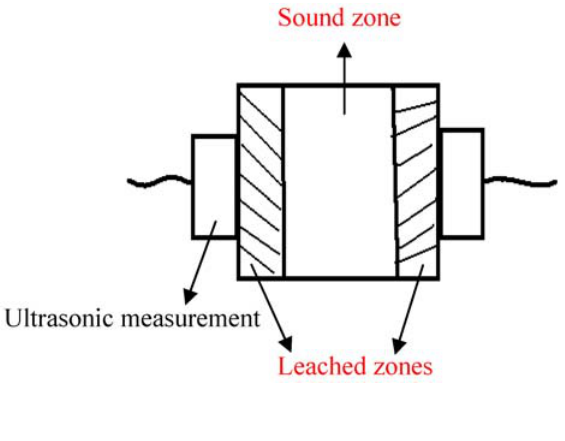
Figure 2. Schematic diagram of an ultrasonic